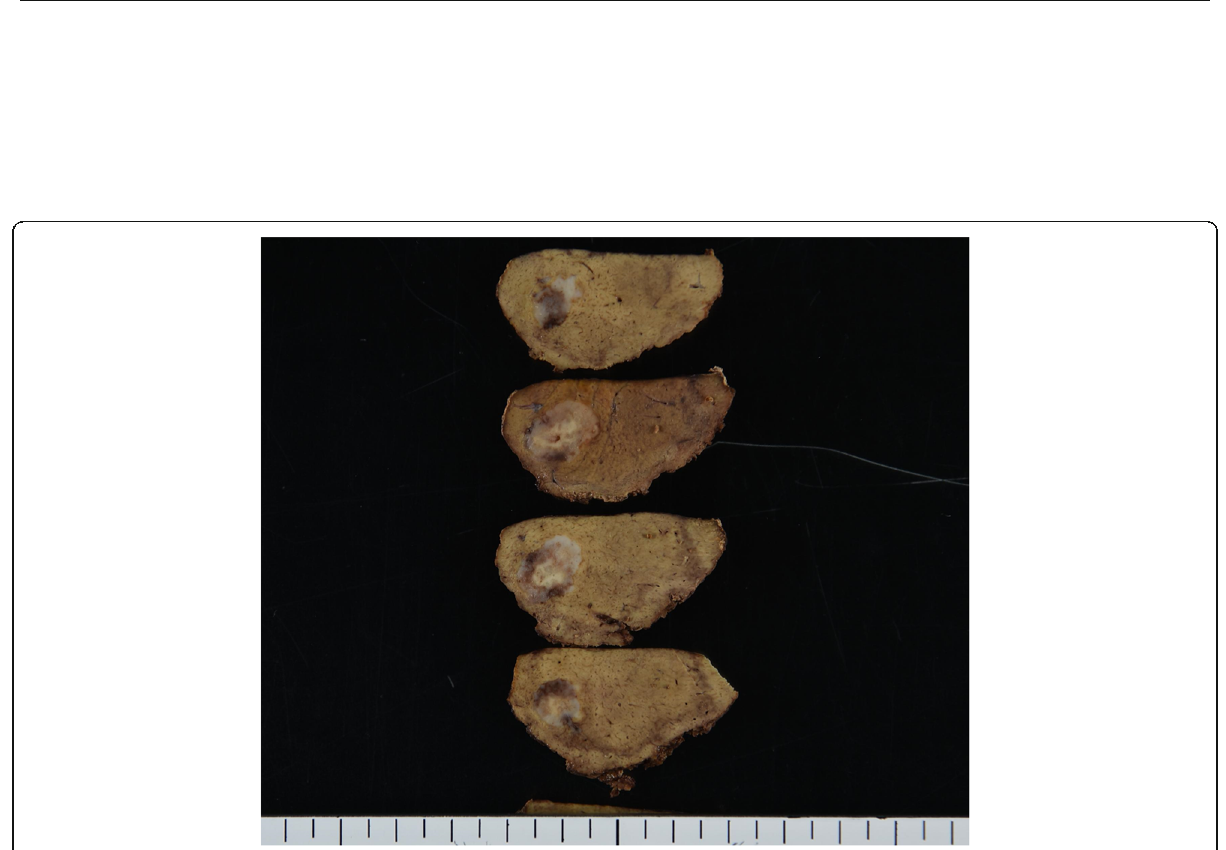
Fig. 5 Macroscopic examination of the revealed specimen showed a nodular 10 × 9 mm tumor under the liver subcapsular